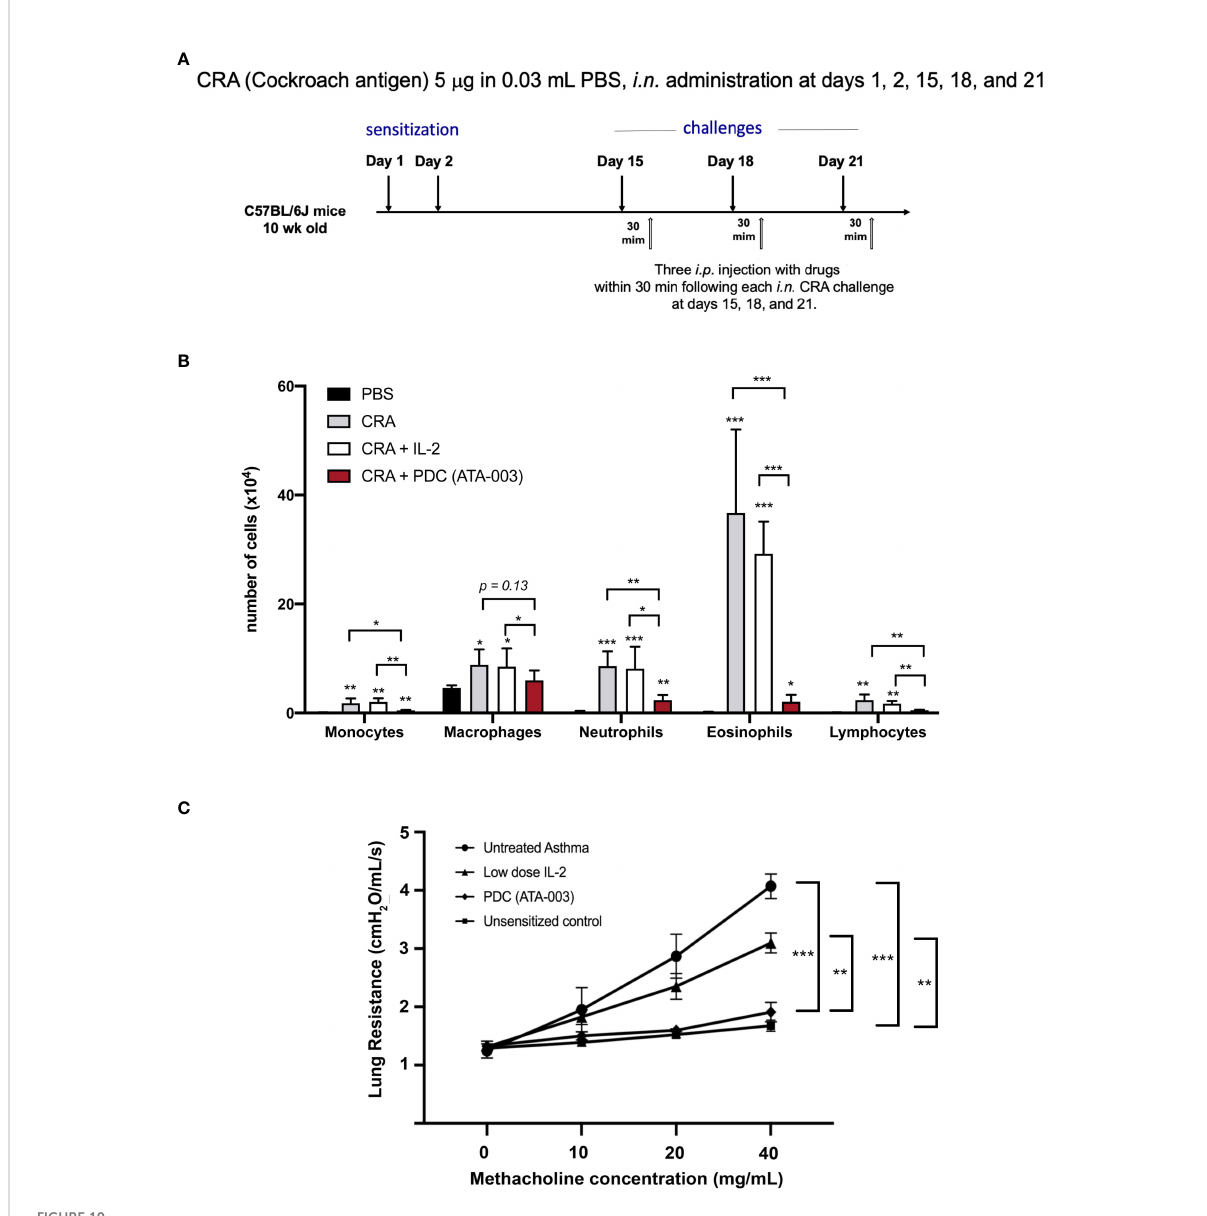
FIGURE 10 Therapeutic effect to the PDC in a CRA-induced animal model of asthma. (A) Asthma was induced in C57/BL6J mice. (B) In one cohort of mice, the recruitment of leukocytes into the lung air spaces (diapedesis) was measured 24 h after the last treatment with PDC (2 m g), IL-2 (1 m g 25,000 IU) or an equal volume of saline (0.1 ml). *p < 0.05, ** p < 0.01, *** p < 0.001 compared to PBS -treated group or groups indicated. (C) In a second cohort of mice, pulmonary function was evaluated. Lung resistance for each group was compared using two-way ANOVA (Tukey ’ s multiple comparisons test; ***p < 0.001, **p <